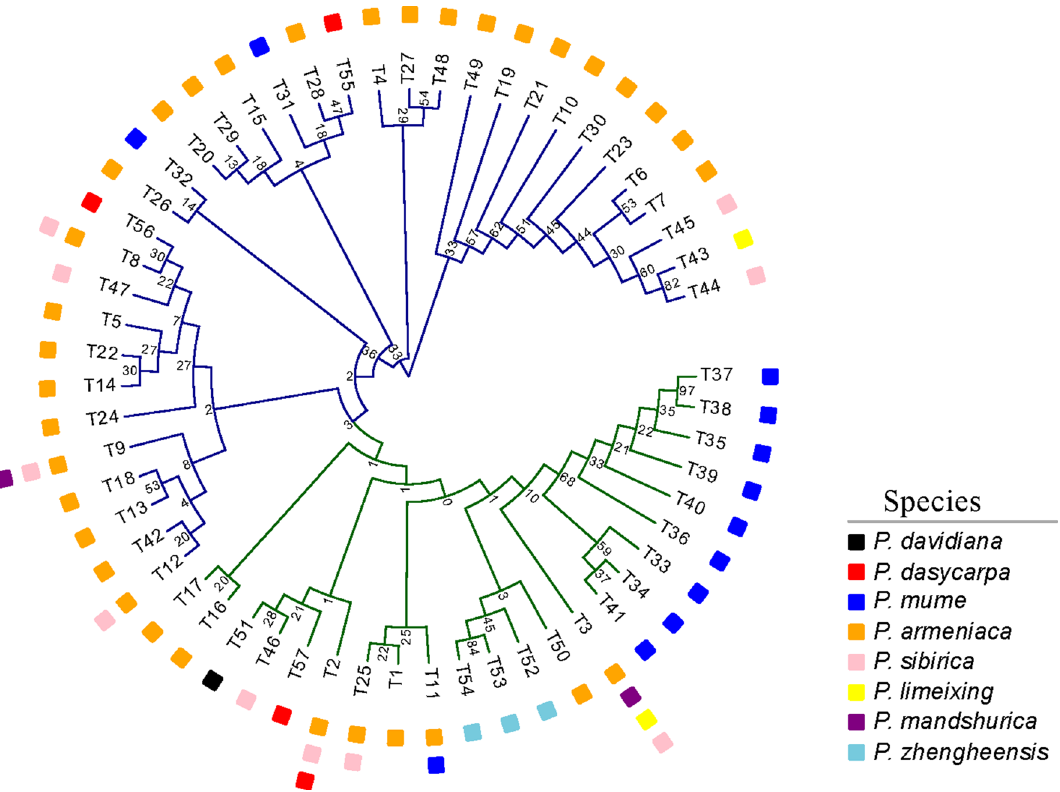
Figure 3. The Neighbor-joning consensus tree (NJ) of Prunus spp. based on genotypes of ITS sequences. The numbers on branches indicate the boostraps values. cpDNA Populations